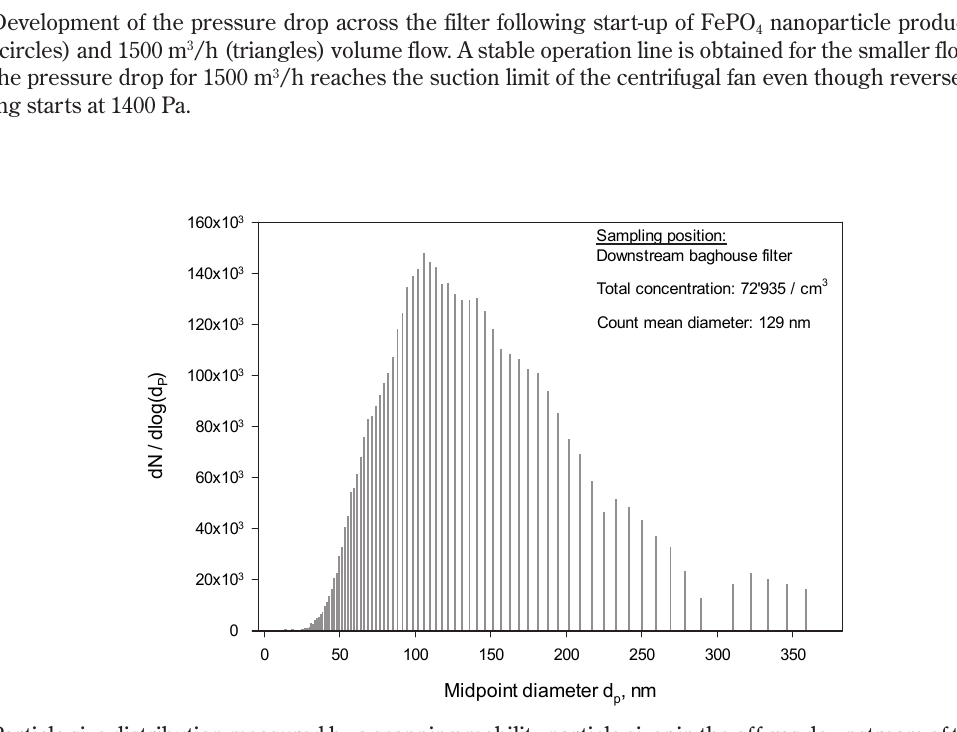
nanoparticle production at 1125 4